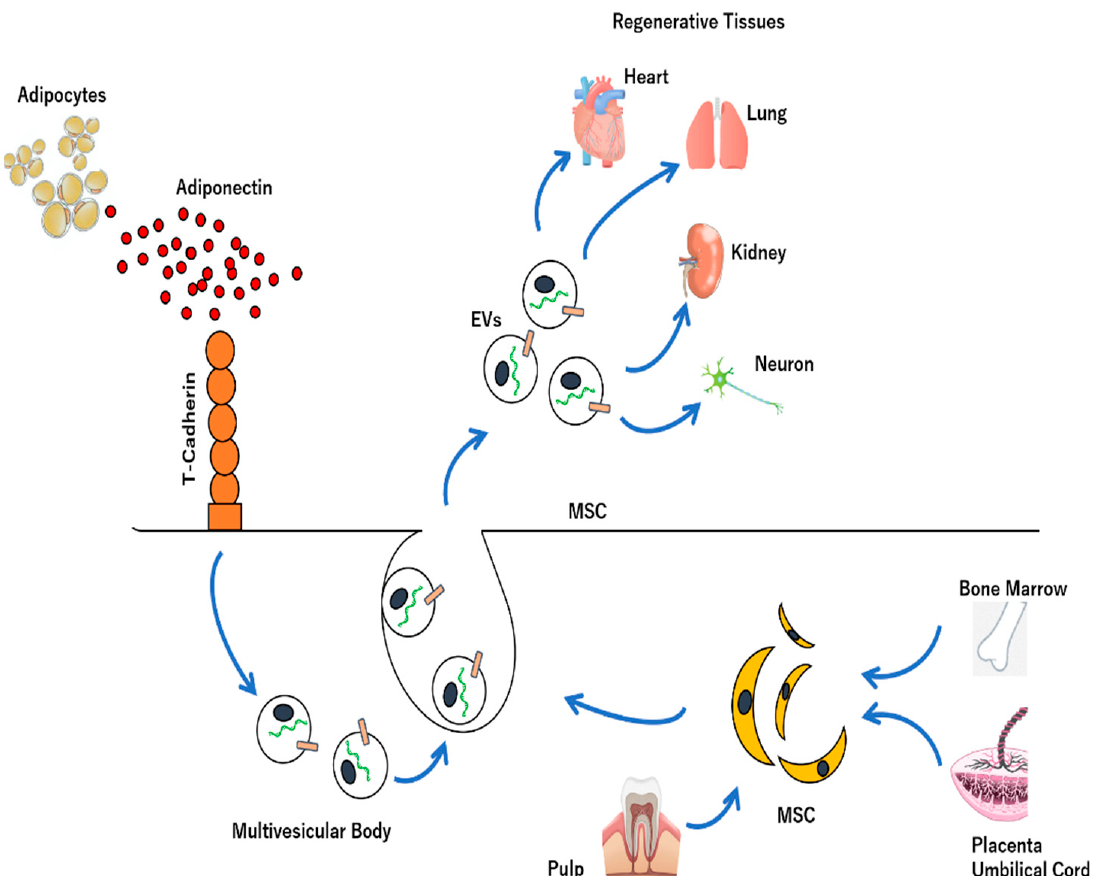
Figure 2. Regeneration effects of MSC-derived extracellular vesicles (MSC-EVs). MSC-EVs have different sources, including adipocytes, bone marrow, umbilical cord, pulp, etc. These MSC-EVs represent regenerative effects for heart, lung, kidney, neuron, etc. Further, MSC promotes secretion of EVs via interaction between T-cadherin receptor on the MSC and adiponectin derived from adipocytes, leading to regeneration effects of injured tissues.